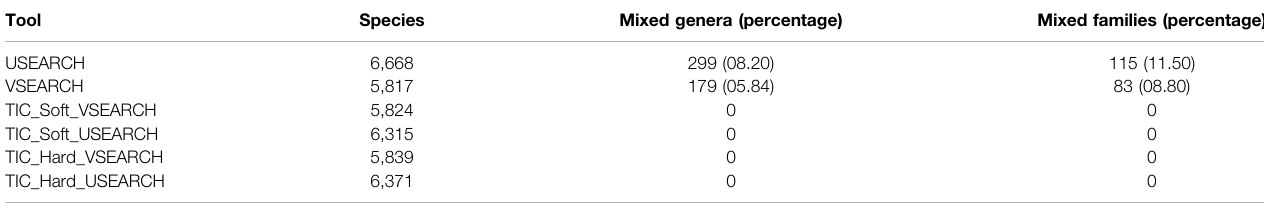
TABLE 2 | Level of impurity for genus and family level clusters created by USEARCH and VSEARCH compared with the TIC approach for the LTP dataset. Tool